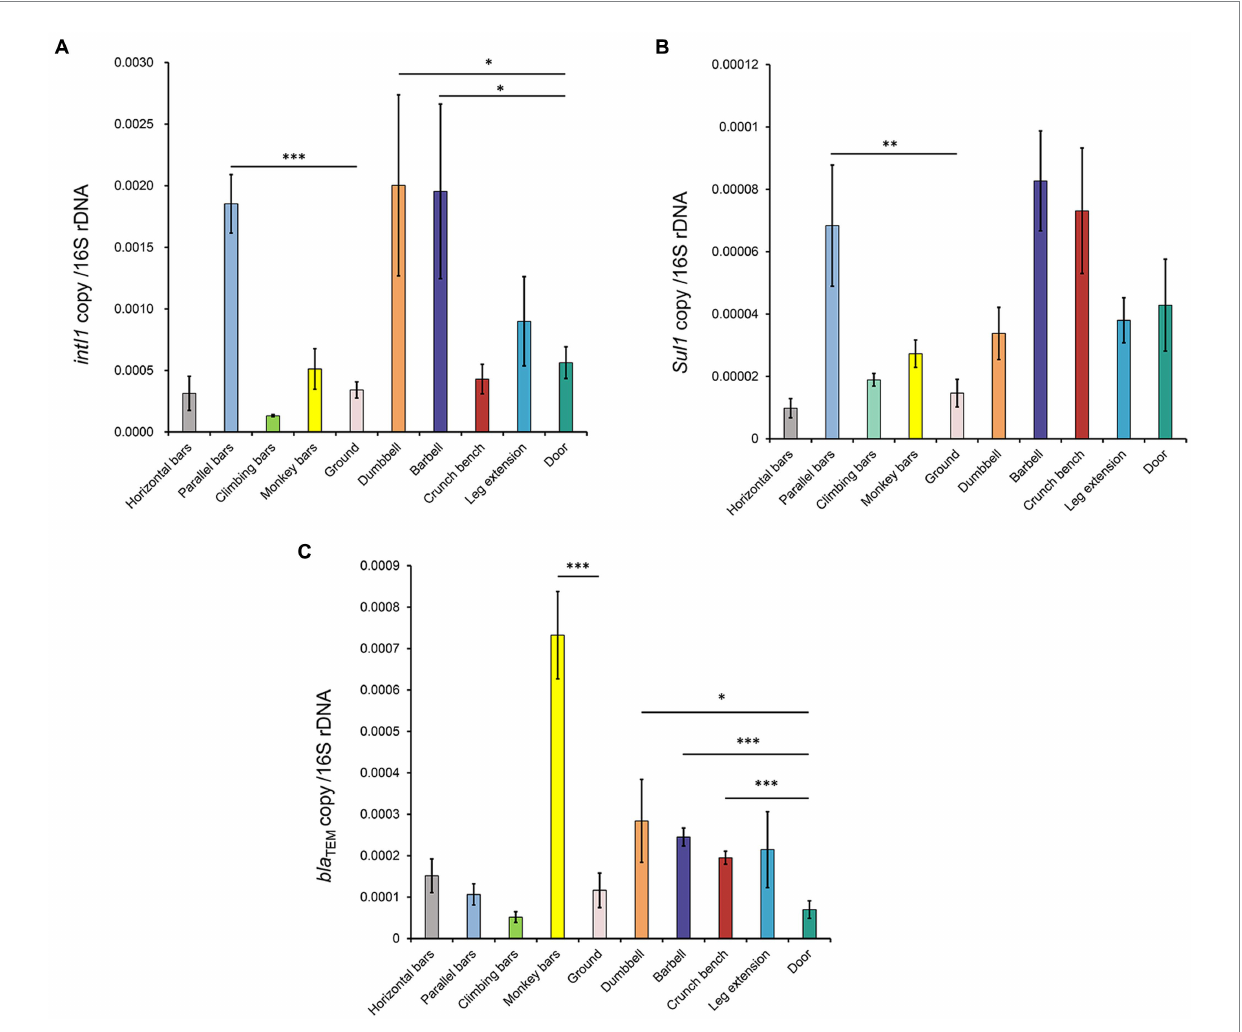
FIGURE 5 Normalized abundance of ARGs on the surfaces of gymnastic equipment. (A) intI1 . (B) sul1 . (C) bla TEM . * , p < 0.05; ** , p < 0.01; *** , p <